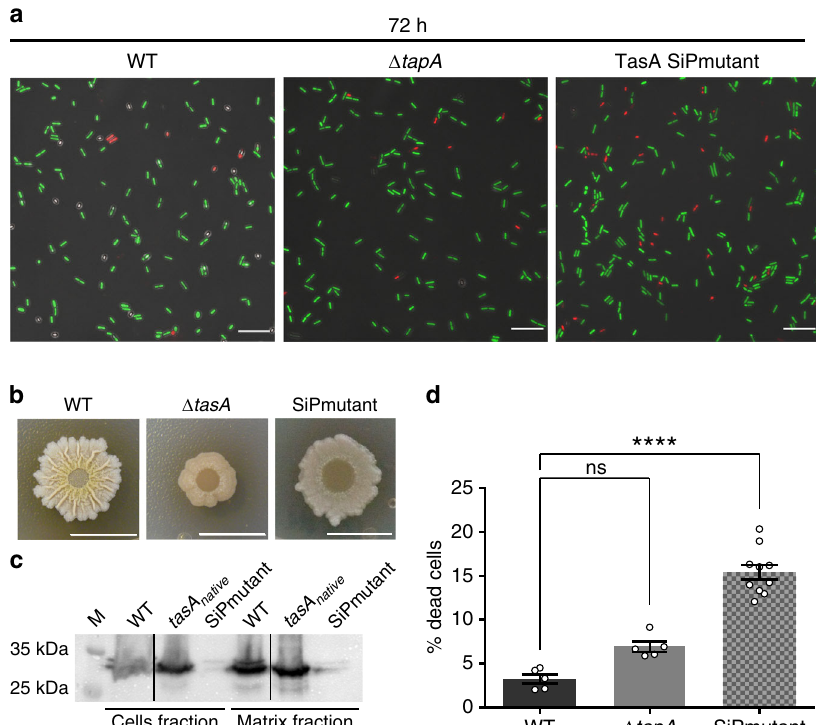
Fig. 8 Mature TasA is required to stabilize cell viability within the colony. a Representative confocal microscopy images of fi elds corresponding to LIVE/ DEAD-stained WT, Δ tapA or signal peptide mutant (SiPmutant, Lys4Ala, Lys5Ala, Lys6Ala) cells at 72 h. Scale bars = 10 µ m. b Colony phenotypes of WT, Δ tasA and the SiPmutant strains on MSgg agar at 72 h. Scale bars = 1 cm. c Western blot of the cell and matrix fractions of the three strains at 72 h exposed to an anti-TasA antibody. Experiments have been repeated at least three times with similar results. Immunoblot images have been cropped and spliced for illustrative purposes. Black lines over the blot images delineate boundaries of immunoblot splicing. The three slices shown are derived from a single blot. Raw images of the blots presented in this fi gure can be found in the source data fi le available with this manuscript. d Quanti fi cation of the proportion of dead cells in WT ( N = 5), Δ tapA ( N = 5), or SiPmutant ( N = 10) colonies at 72 h. N refers to the number of colonies examined over three independent experiments. The WT data in Fig. 4 is from the same experiment as the data displayed in this fi gure and has been used as a control for the comparison between the WT, Δ tapA and SiPmutant colonies. Error bars represent the SEM. For each experiment and sample, at least three fi elds-of-view were measured. Statistical signi fi cance was assessed via two-tailed independent t -tests at each time-point (**** p < 0.0001). Source data are provided as a Source Data fi